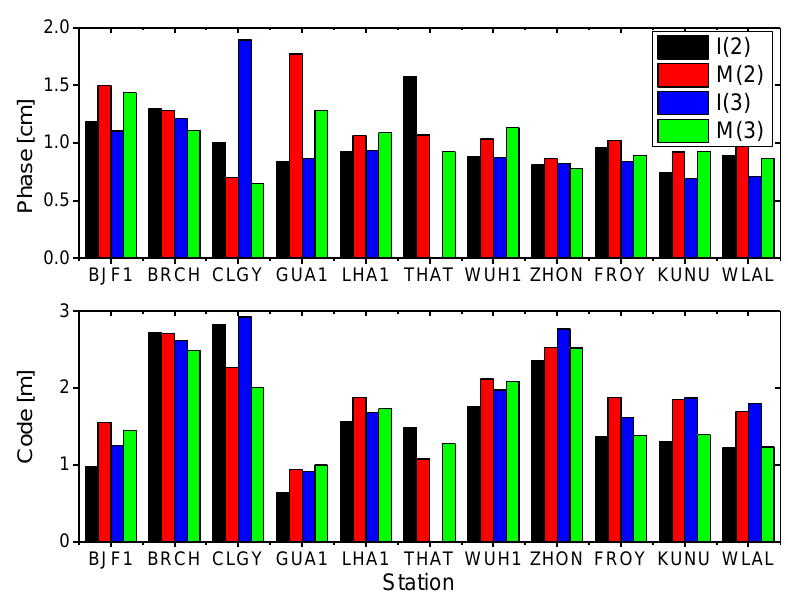
Figure 2. Mean RMS values of the station-specific post-fit residuals of ionosphere-free linear combination of B1 and B3 code and phase observations for BDS-2 and BDS-3 satellites. I(2) and M(2) represent BDS-2 IGSO (C06, C07, C08, C09, C10) and MEO (C11, C12, C14) satellites, and I(3) and M(3) represent BDS-3 IGSO (C31, C32) and MEO (C33, C34) satellites, respectively.